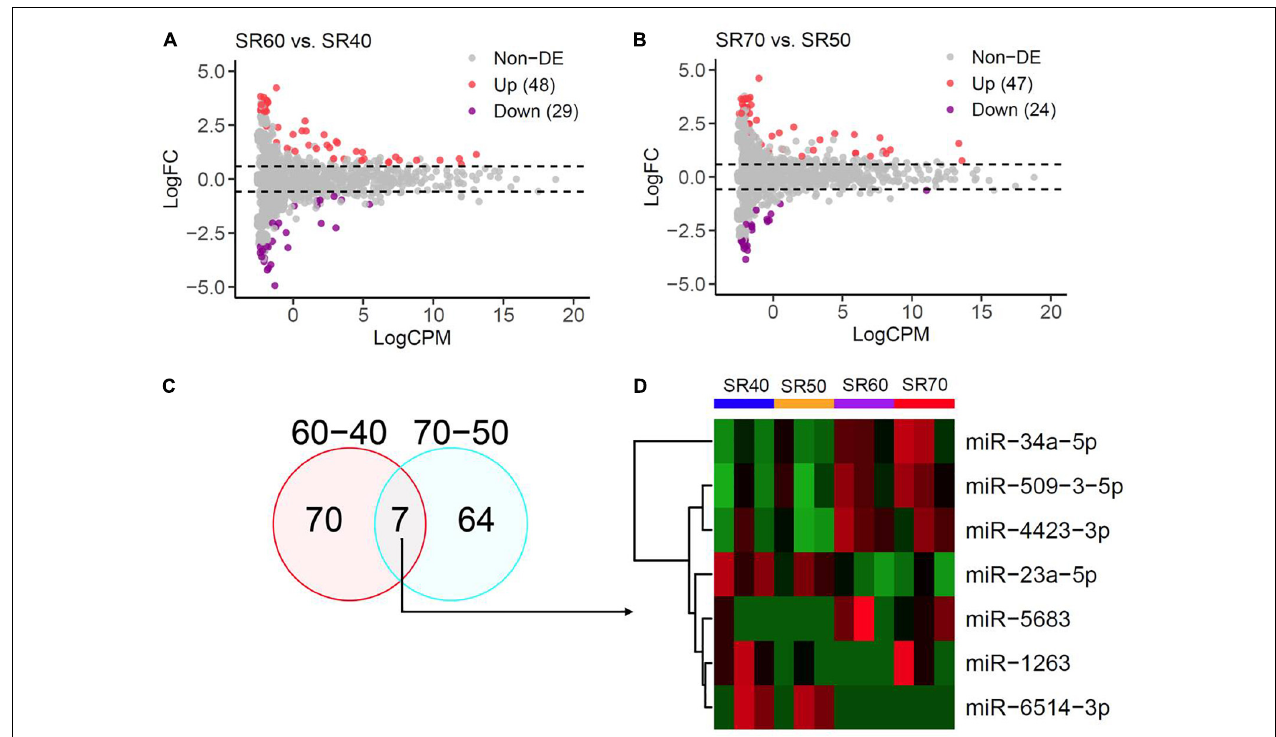
FIGURE 1 | miRNA-seq analysis of human atrial samples with SR. (A) Differential expression analysis of 1,482 miRNAs between 60 and 40 years old group. X -axis, miRNA expression was quantified as count per million at log2 scale. Y -axis, fold change (SR60/SR40) at log2 scale. (B) Differential expression analysis of 1,482 miRNAs between 70 years old group and 50 years. (C) Venn diagram showing significant miRNAs from the above two comparisons at nominal P < 0.05. (D) Heatmap and hierarchical structure of seven overlapping miRNAs across 12 human atrial